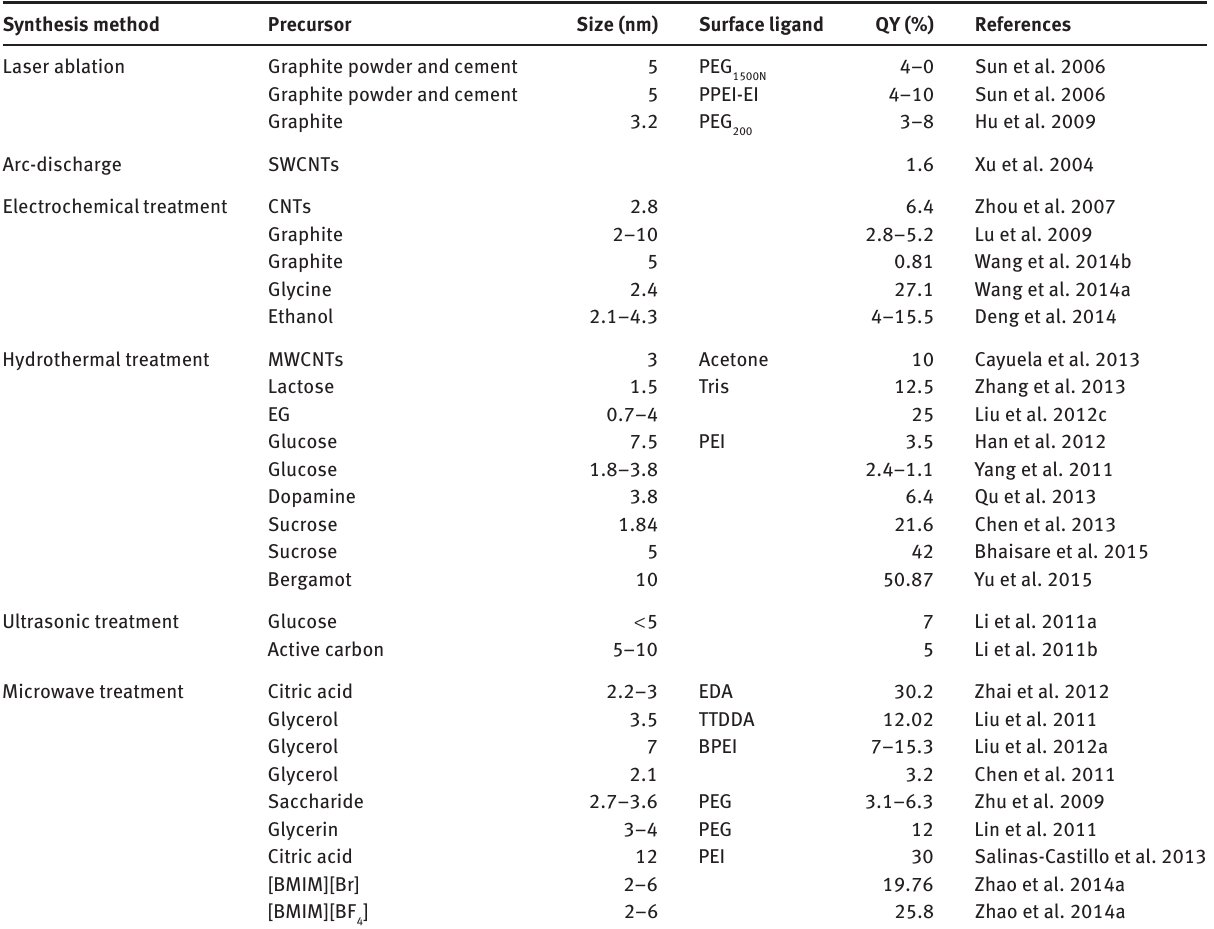
Table 1: Properties of CDs synthesized from different precursors under different synthesis treatments. Synthesis method